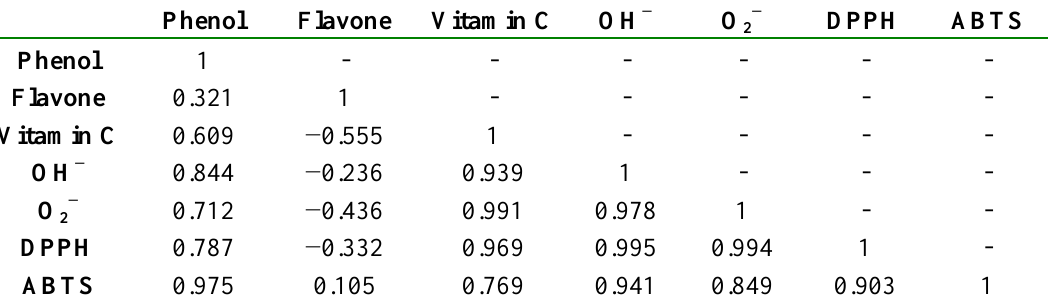
Table 2. Correlation matrix showing the interrelation amongst phenol content,